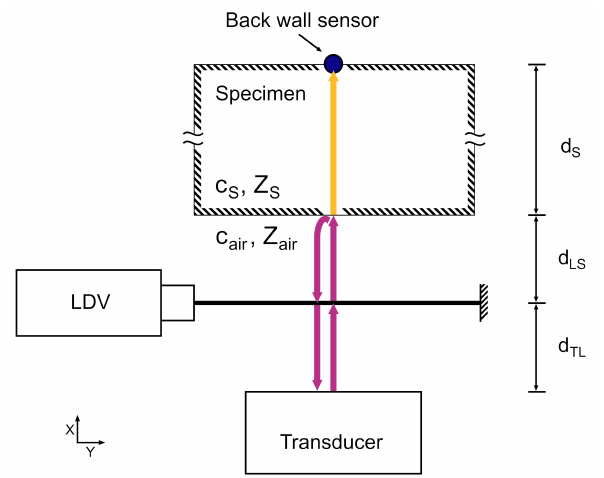
Figure 3. Sketch of the proposed setup. The arrows indicate the sound path through air (purple) and through the specimen (yellow), which are used to determine the signal travel time through air and the specimen. The distances shown are the space between transducer and laser beam ( d TL ), the space between laser beam and specimen ( d LS ), and the thickness of the specimen ( d S ). The sketch additionally shows the speeds of sound ( c S , c air ) of specimen and air, causing the time